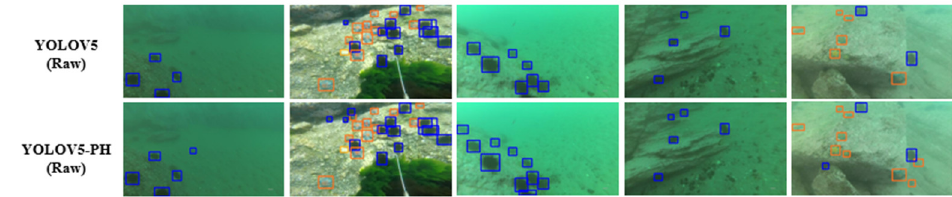
Figure 7. Performance comparison of prediction head optimization on detection of tiny marine or-